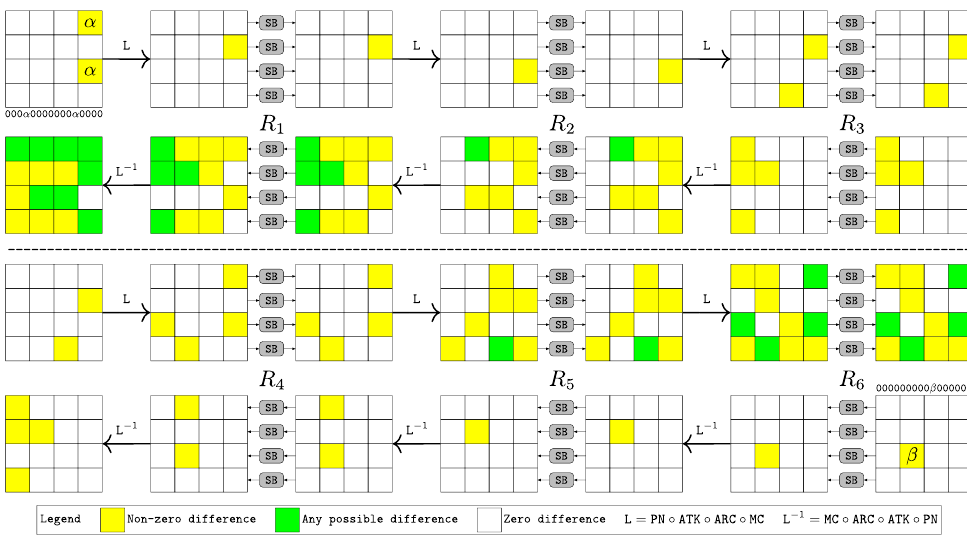
Figure 7: A 6-round boomerang distinguisher of CRAFT